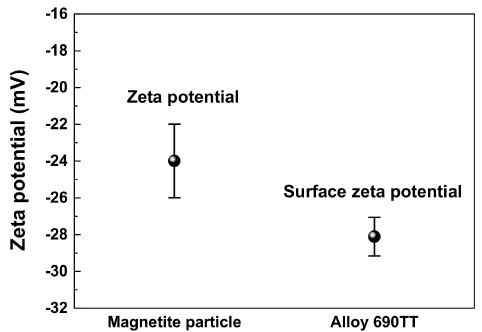
Figure 13. Zeta potentials of magnetite nanoparticle and Alloy 690TT